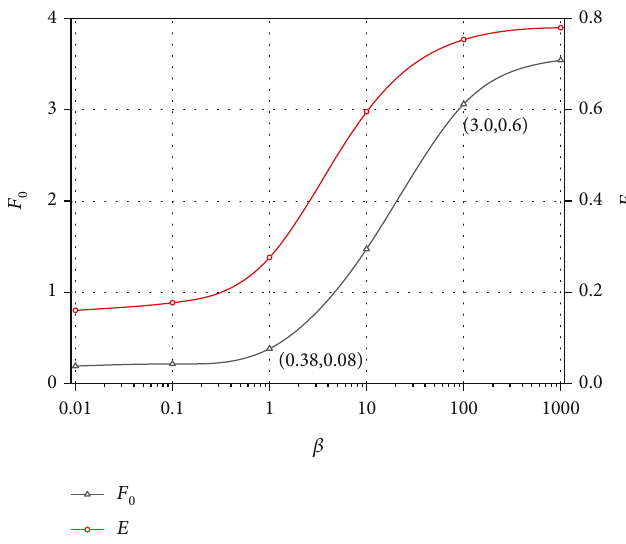
Figure 7: Forchhneimer number and non-Darcy e ff ect E at point A ′ at di ff erent permeabilities.